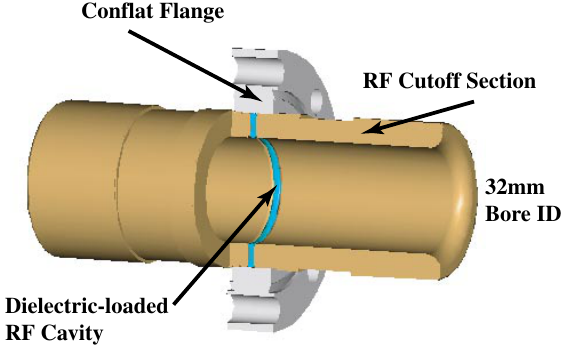
FIG. 8. (Color) Schematic of dipole mode pillbox cavity.